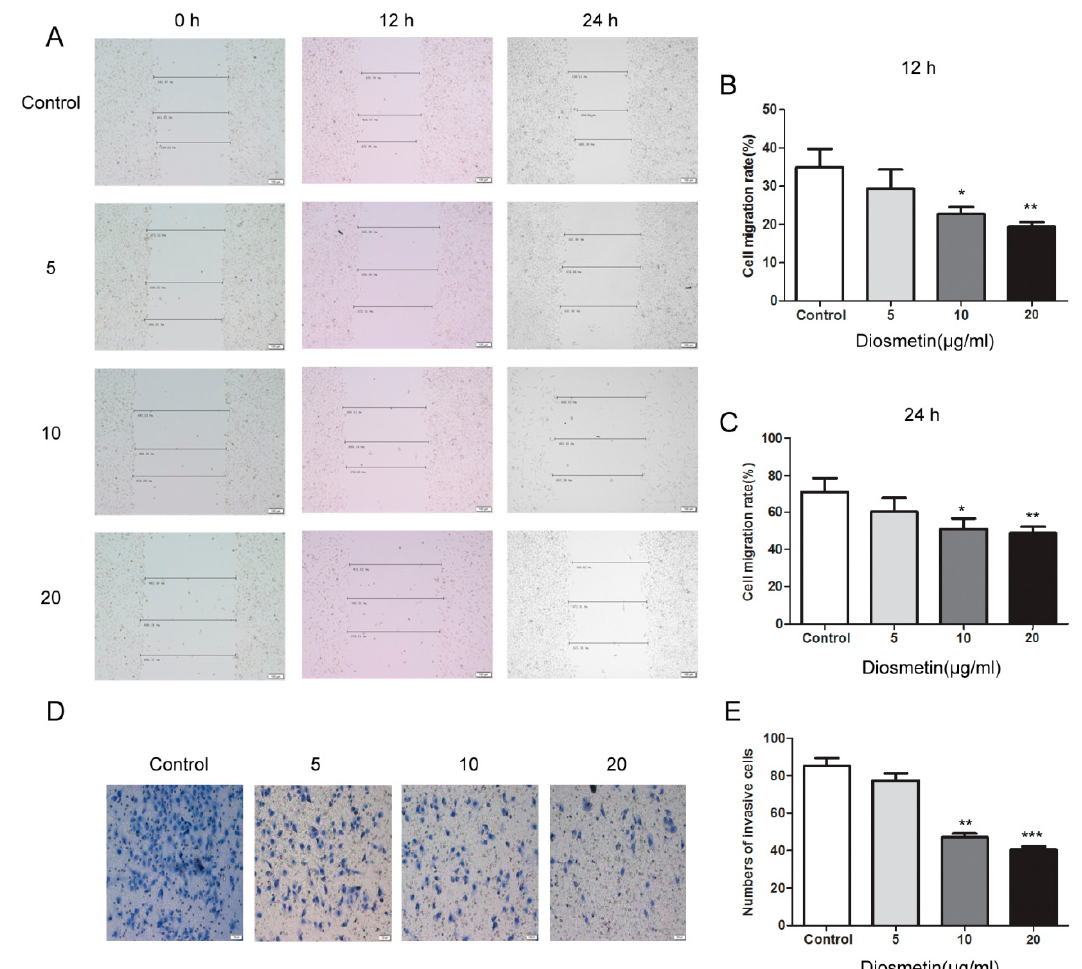
Figure 2. Diosmetin inhibited the invasion and migration of glioma cells. ( A – C ) Cell-scratching assays. ( D , E ) Transwell assays. Compared with group, * p < 0.05, ** p < 0.01, *** p < 0.001.